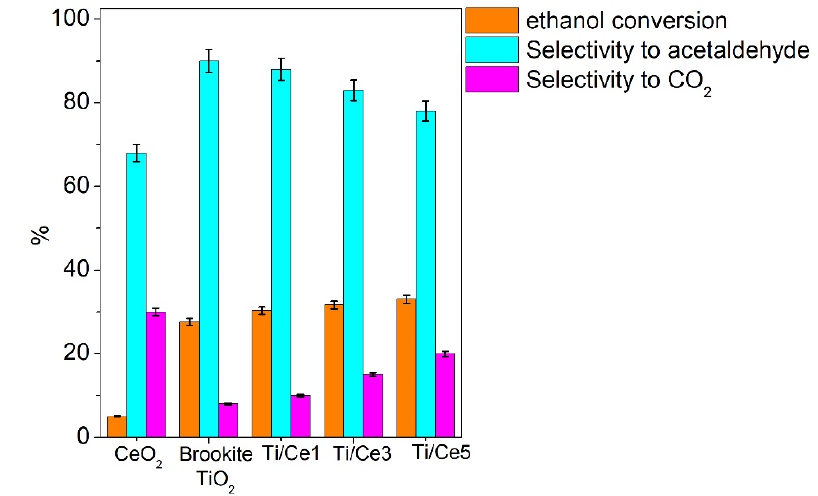
Figure 8. Photocatalytic oxidation of ethanol at room temperature, under simulated solar irradiation for 2 h over the investigated catalysts. Table 6. Ethanol photothermo-catalytic oxidation over the investigated samples.